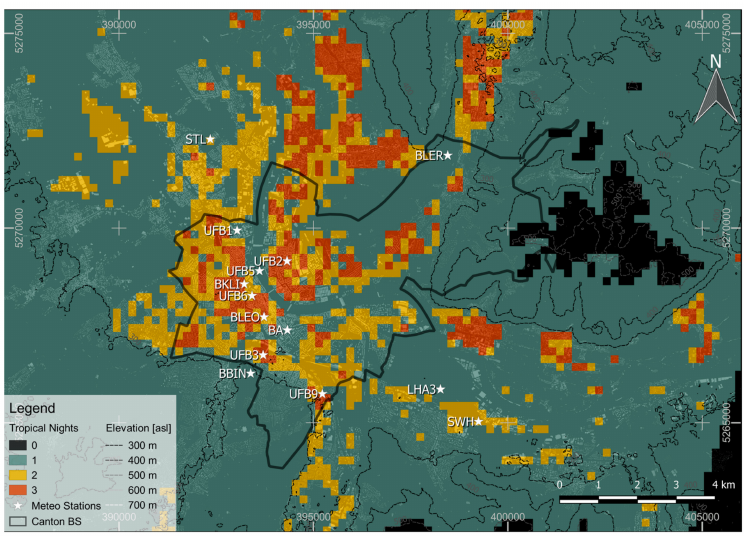
Figure 8. Number of tropical nights (T min > 20 ◦ C) between the 23 and the 29 August 2016 based on the model prediction in a 200-m grid. A DOM behind the data layer depicts the city structure and contour lines describe the topography. The coordinate system is